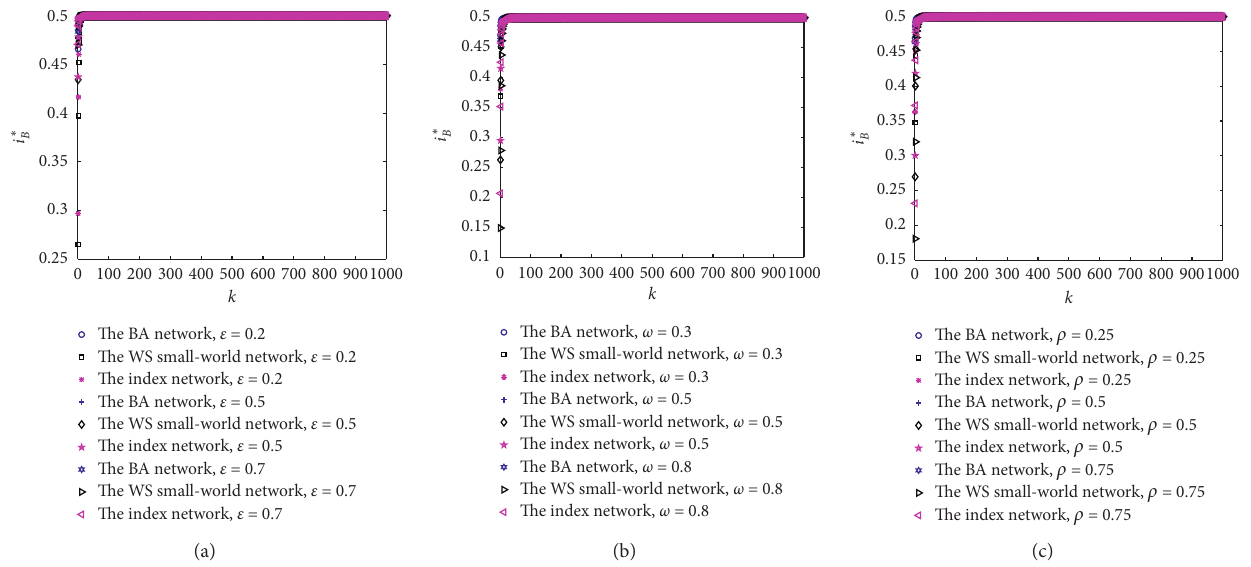
Figure 8: Evolutionary characteristics of the effect of the degree k of the enterprise’s counterparty on i ∗ B in the bank network under different network structures and different levels of bank transaction counterparty business association ε . (b) The degree k of the corporate counterparty on i ∗ B in the bank network under different network structures and different bank counterparty risk resistance abilities ω . (c) The degree k of the corporate counterparty on i ∗ B in the bank network under different network structures and bank’s counterparty risk information processing abilities ρ